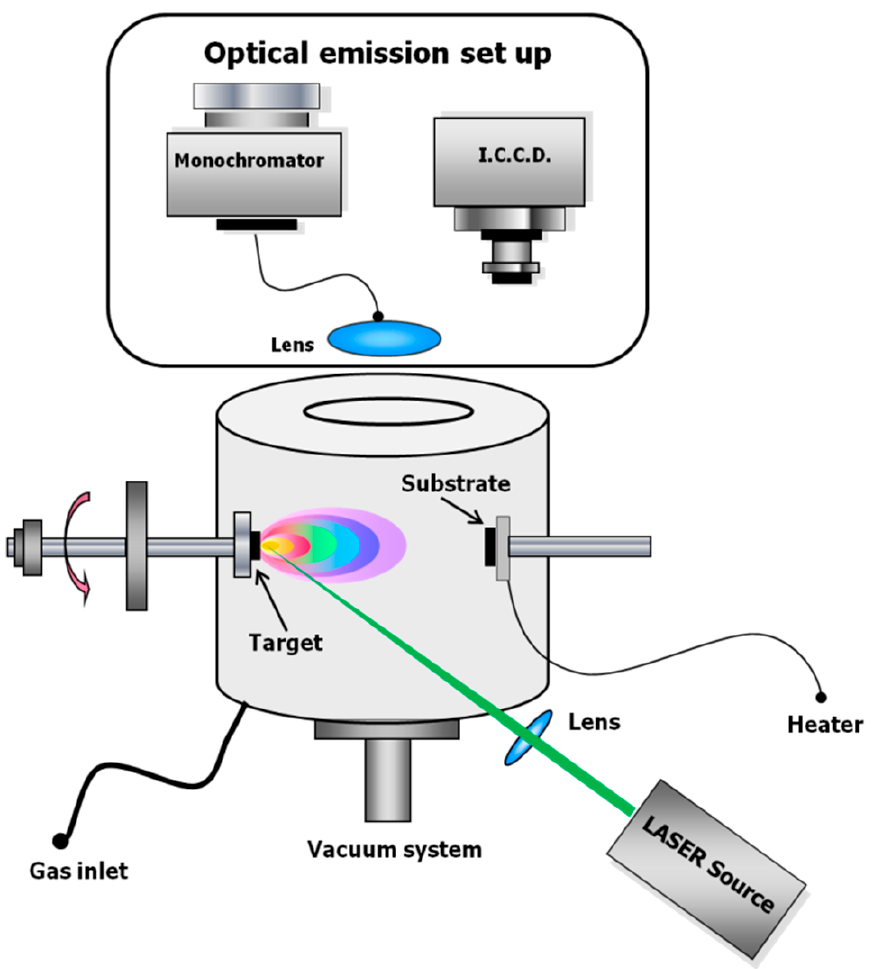
Figure 1. Experimental set-up for pulsed laser ablation and deposition.